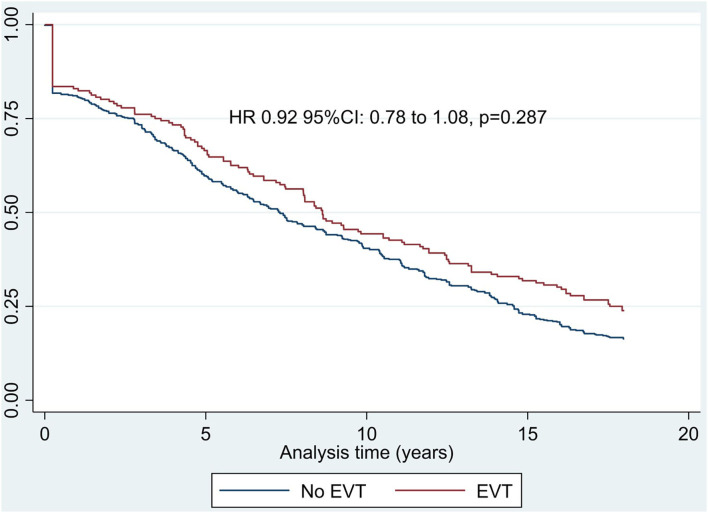
Cox proportional hazards regression for the long-term modeled survival.